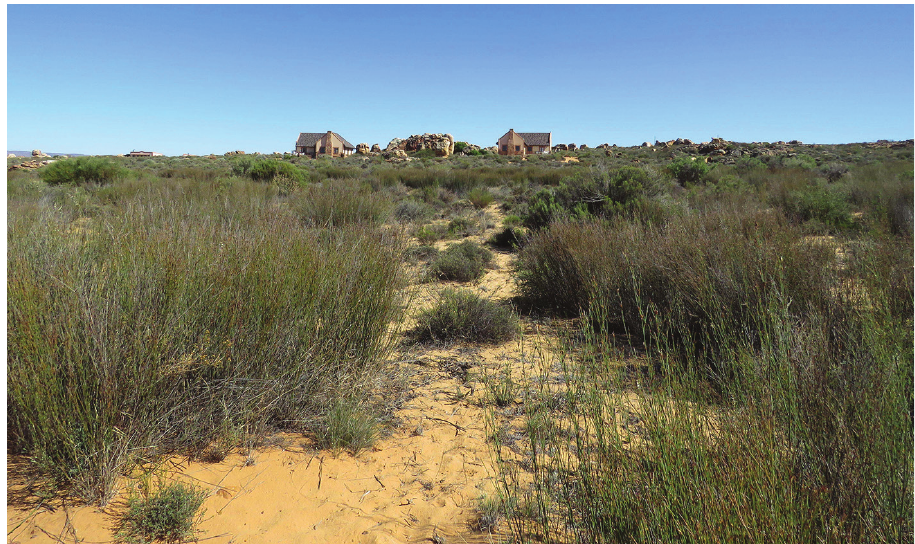
Figure 15. Typical habitat of both Gibbasilus condylus sp. n. and G. crinitus sp. n. – Kagga Kamma Nature Reserve, where both species may be found